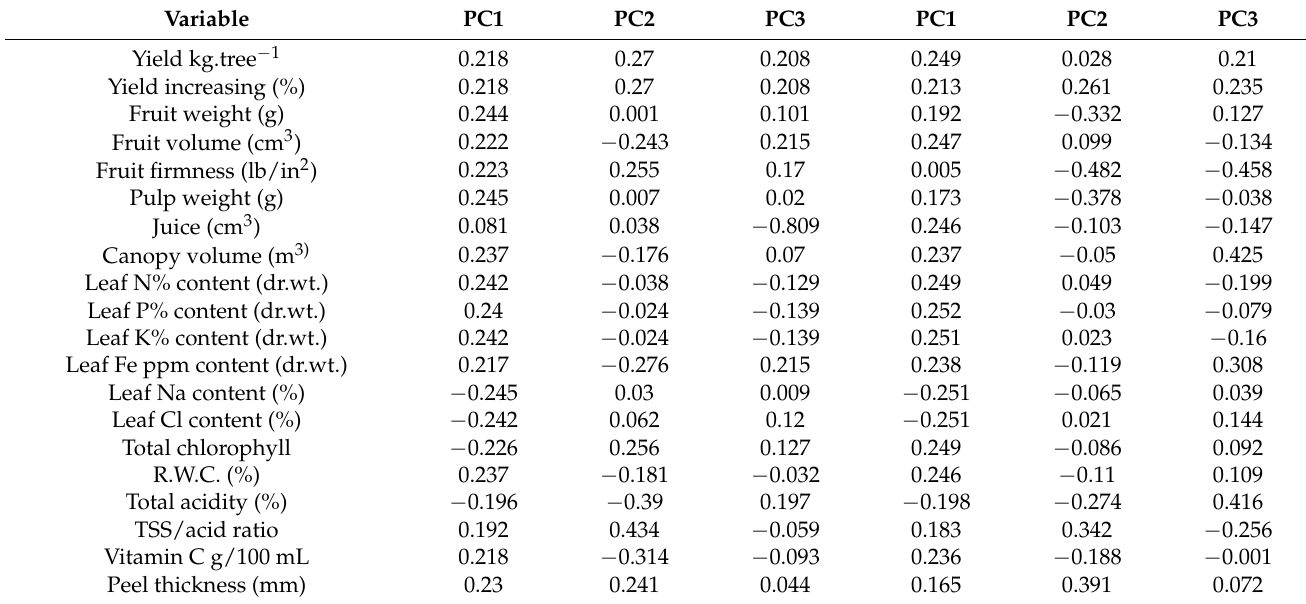
Table 1. Results of principal component analysis (PCA) of effect of magnetic iron application on fruit chemical properties of ‘Chinese’ mandarin trees during 2019 and 2020